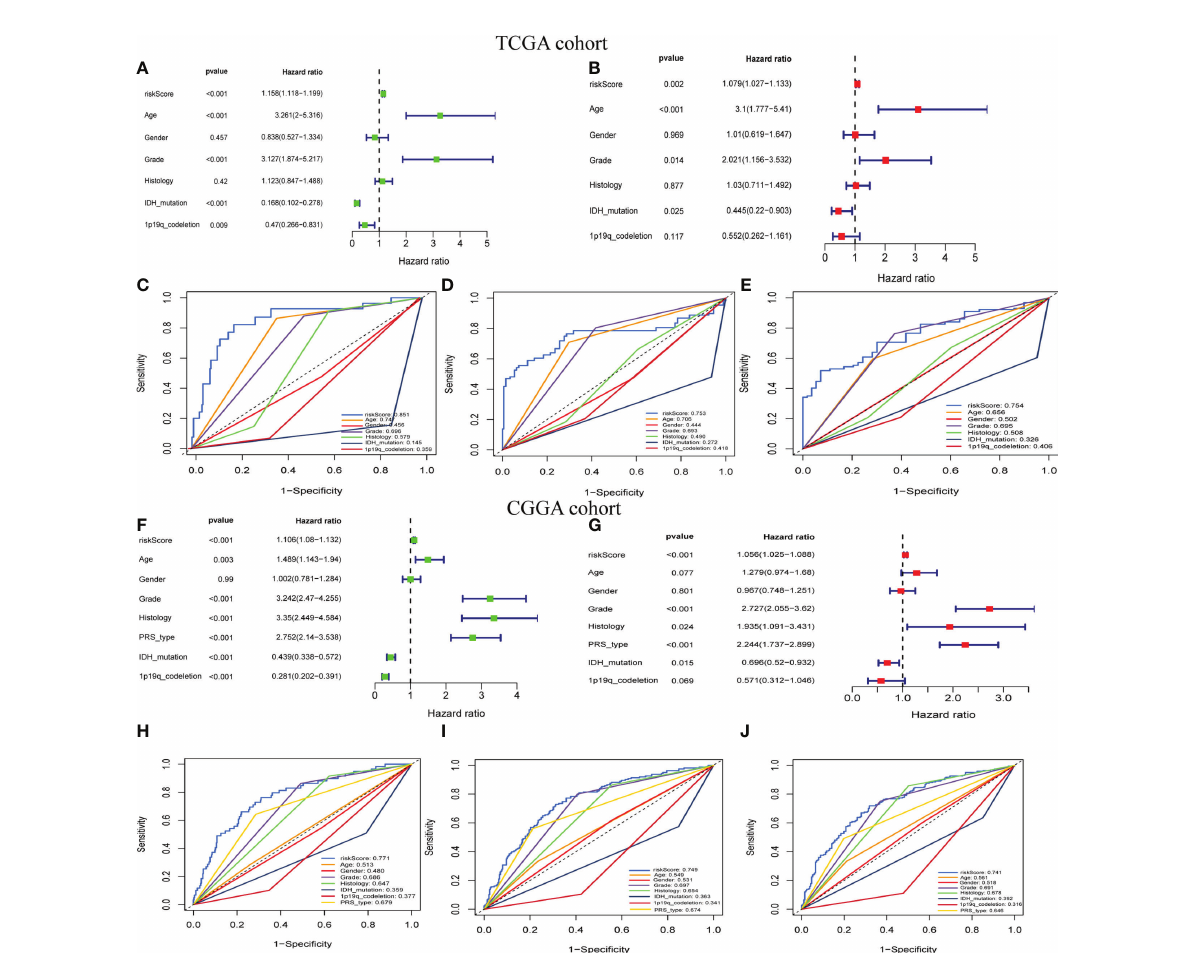
FIGURE 3 The prognostic value of GSRS. (A, B) In the training set, the forest plot on the left is for the univariate and multivariate Cox analysis evaluating the association of the risk score and clinical factors with patient OS. The ROC curve of risk score and clinical factors for predicting 1-year (C) , 3- year (D) , and 5-year (E) OS. (F, G) In the validation set, univariate and multivariate Cox analysis of risk score and clinical factors. ROC curve of risk score compared with other clinical factors for predicting 1 - year (H) , 3-year (I) , and 5-year (J) OS.